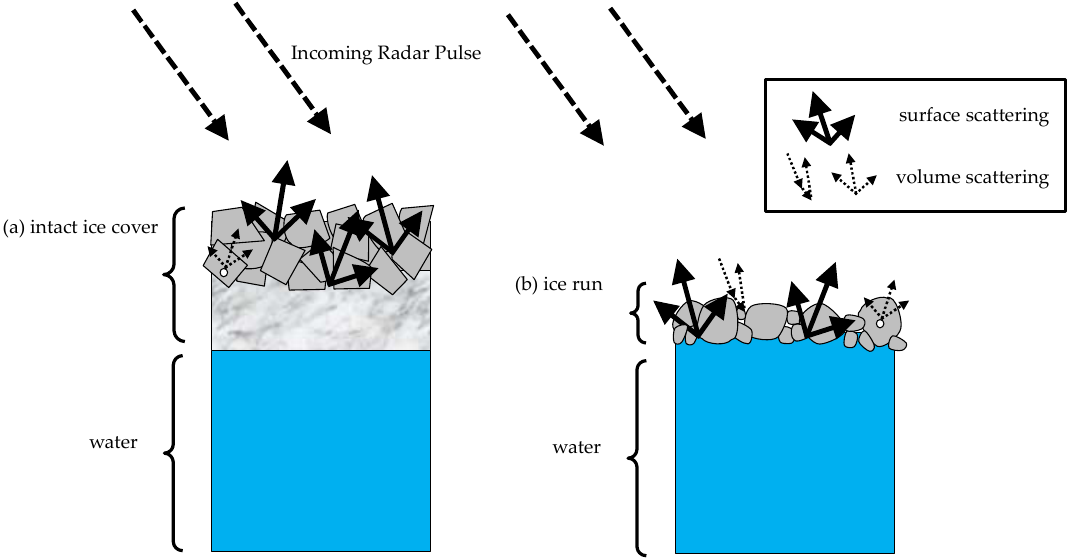
Figure 2. The scheme of surface and volume scattering of fully polarimetric SAR (Synthetic Aperture Radar) images for differentiating ( a ) intact ice covers and ( b ) ice runs (adapted from Gherboudj et al. [19]).